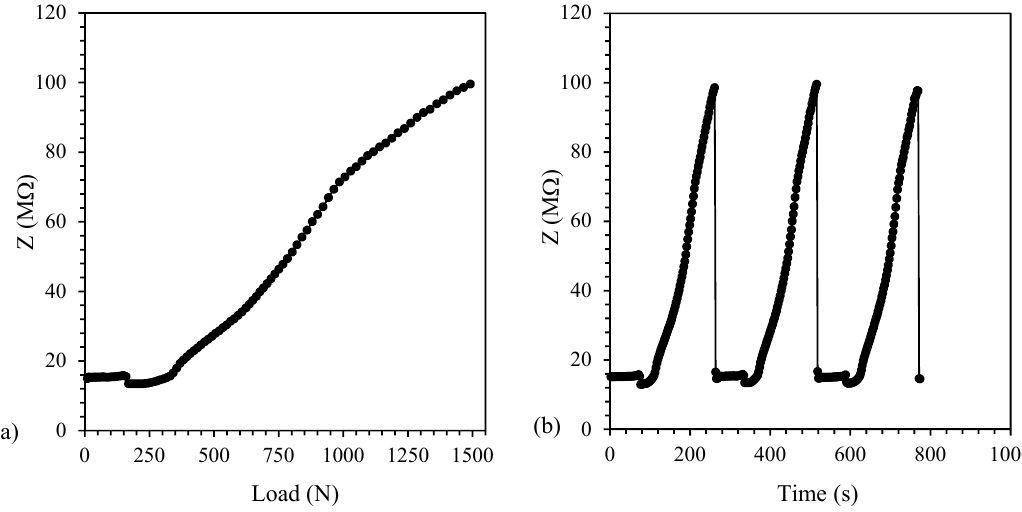
Figure 11. Impedance value for PP / CNT-5 nanocomposites. ( a ) Impedance (Z) variation vs. load and ( b ) load / unload